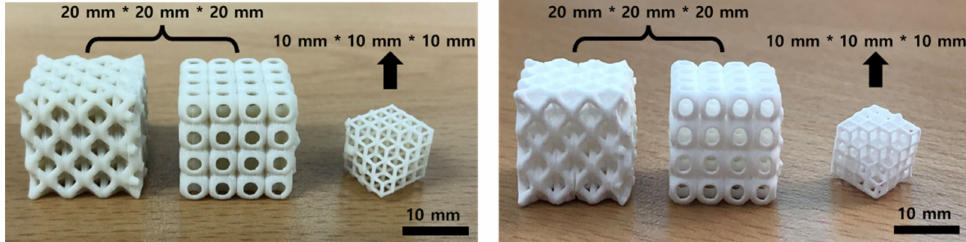
Figure 9. Ceramic with a lattice structure using DLP 3D printing. ( a ) Green bodies, ( b ) sintered